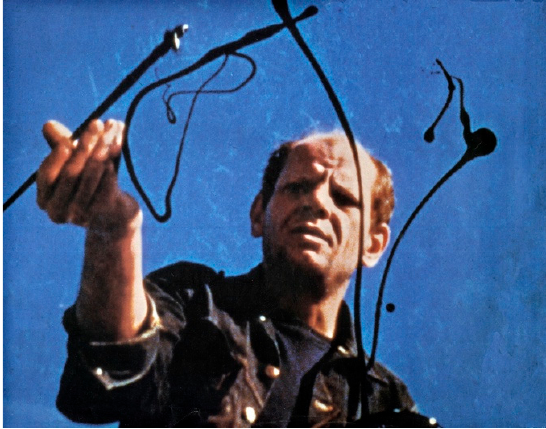
Figure 24. Pollock working on a painting on glass, in November of 1950. Frame from a color film by Hans Namuth and Paul Falkenburg. Pollock ultimately erased this version of the painting.